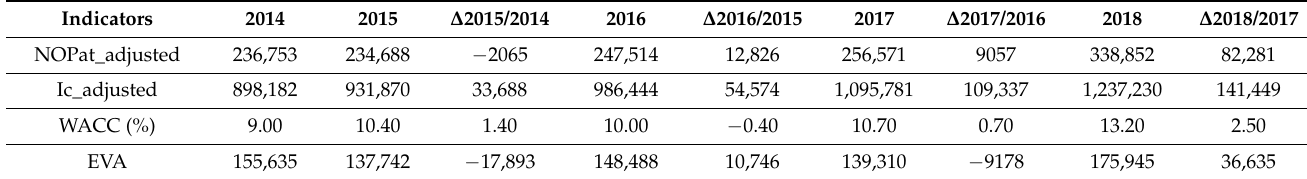
Table 3. Economic value added (thousand